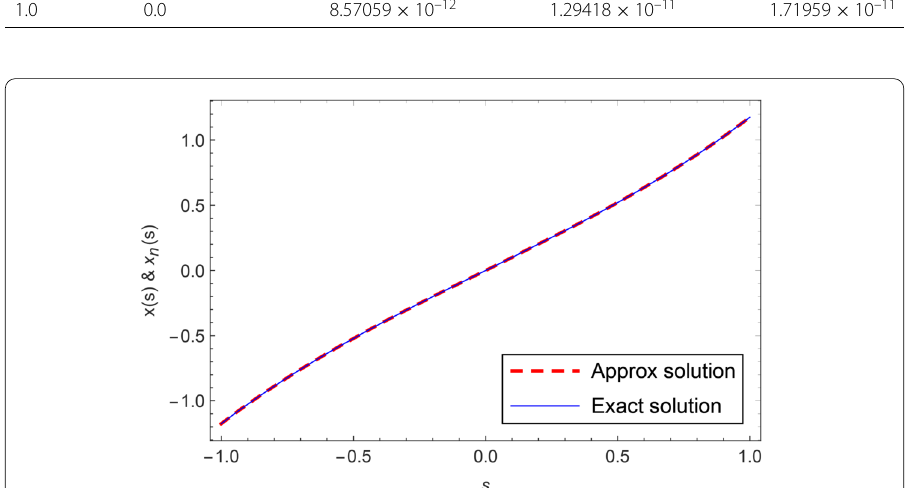
Figure 3 Comparison of solutions for Example 2 with n = 7 and m = 16